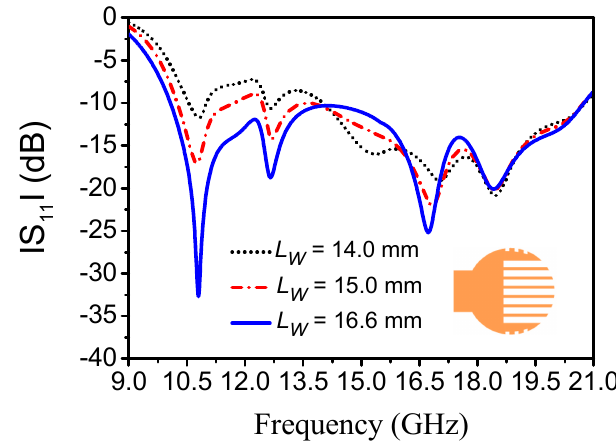
Figure 7. Simulated reflection coefficient of the waveguide-fed SWA respect to different L B .